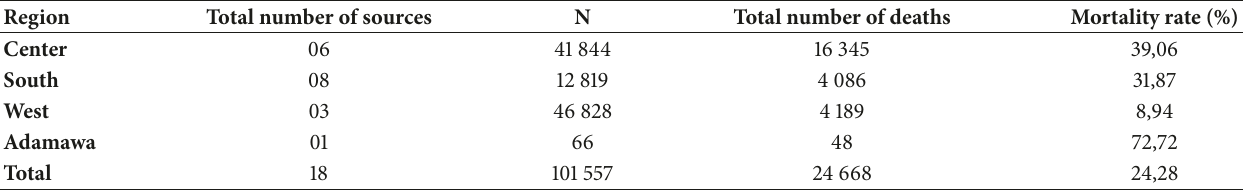
Table 1: Number of sources and mortality rate of the 2016 highly pathogenic avian influenza H5N1 outbreak in Cameroon.